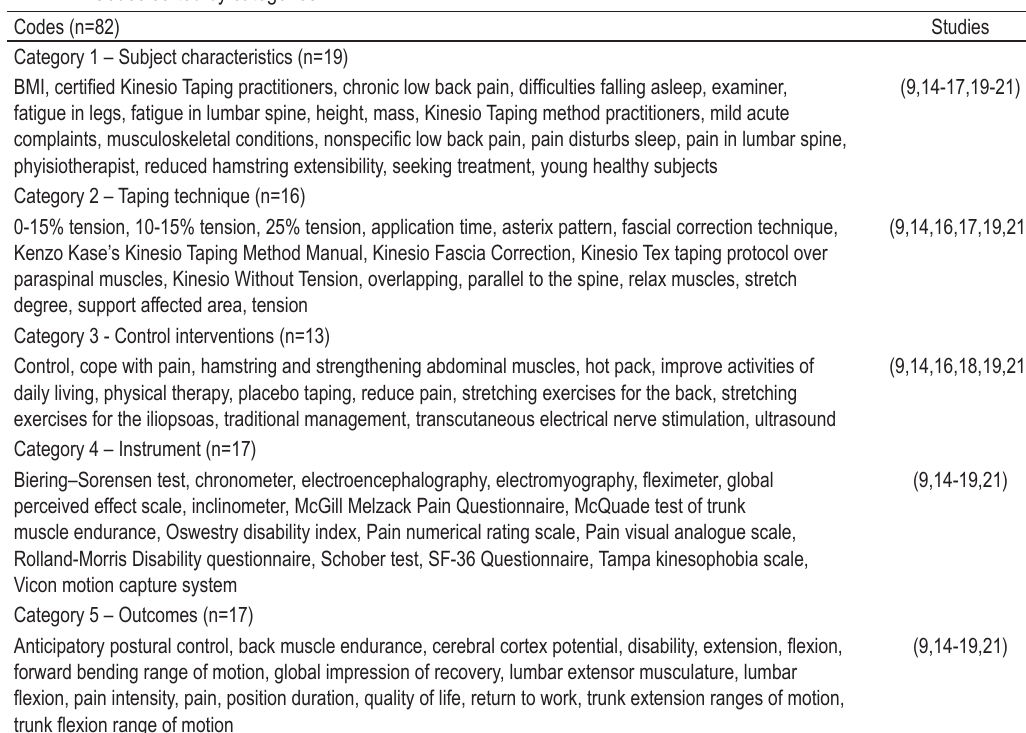
TABLE 2. Codes sorted by categories Codes